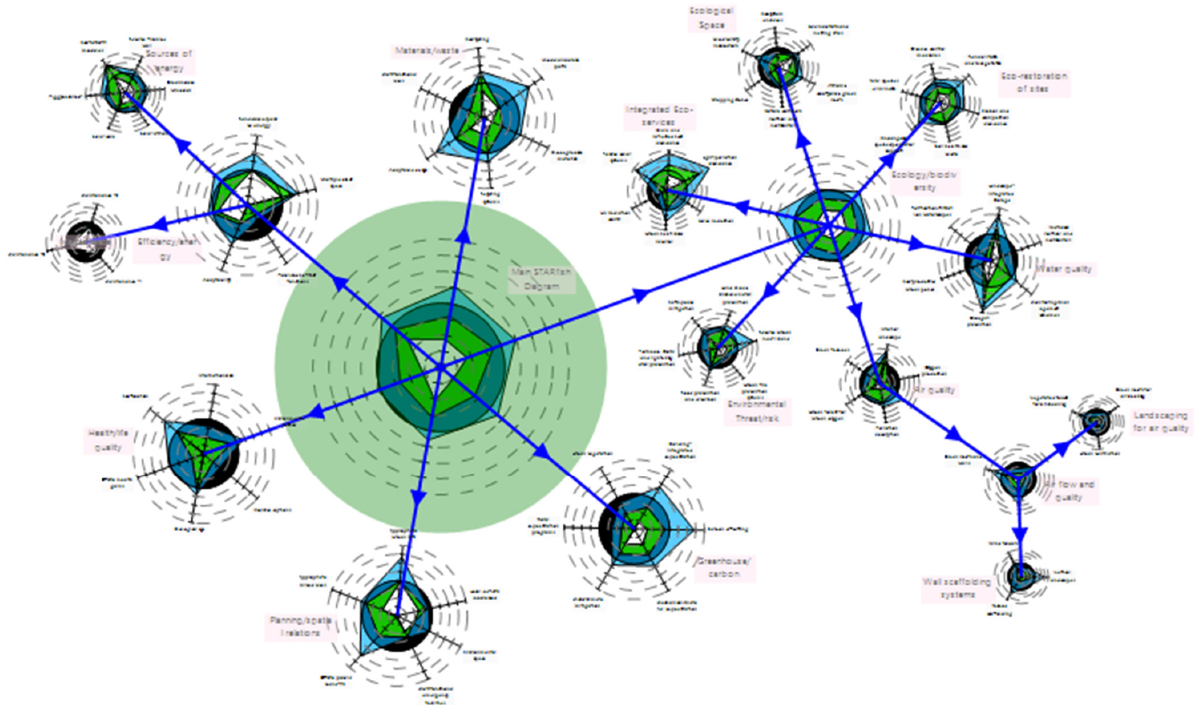
Figure 1. Illustration of the STARfish net-positive design app.